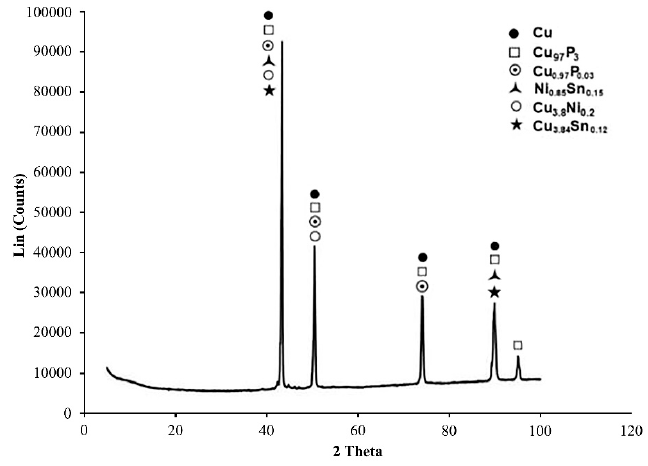
◦ C for 15 min with marked phase